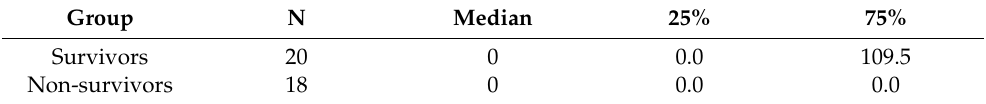
Table 7. Results of eosinophil counts (cell/ µ L) depending on survival. Control group was not included. Group N Median